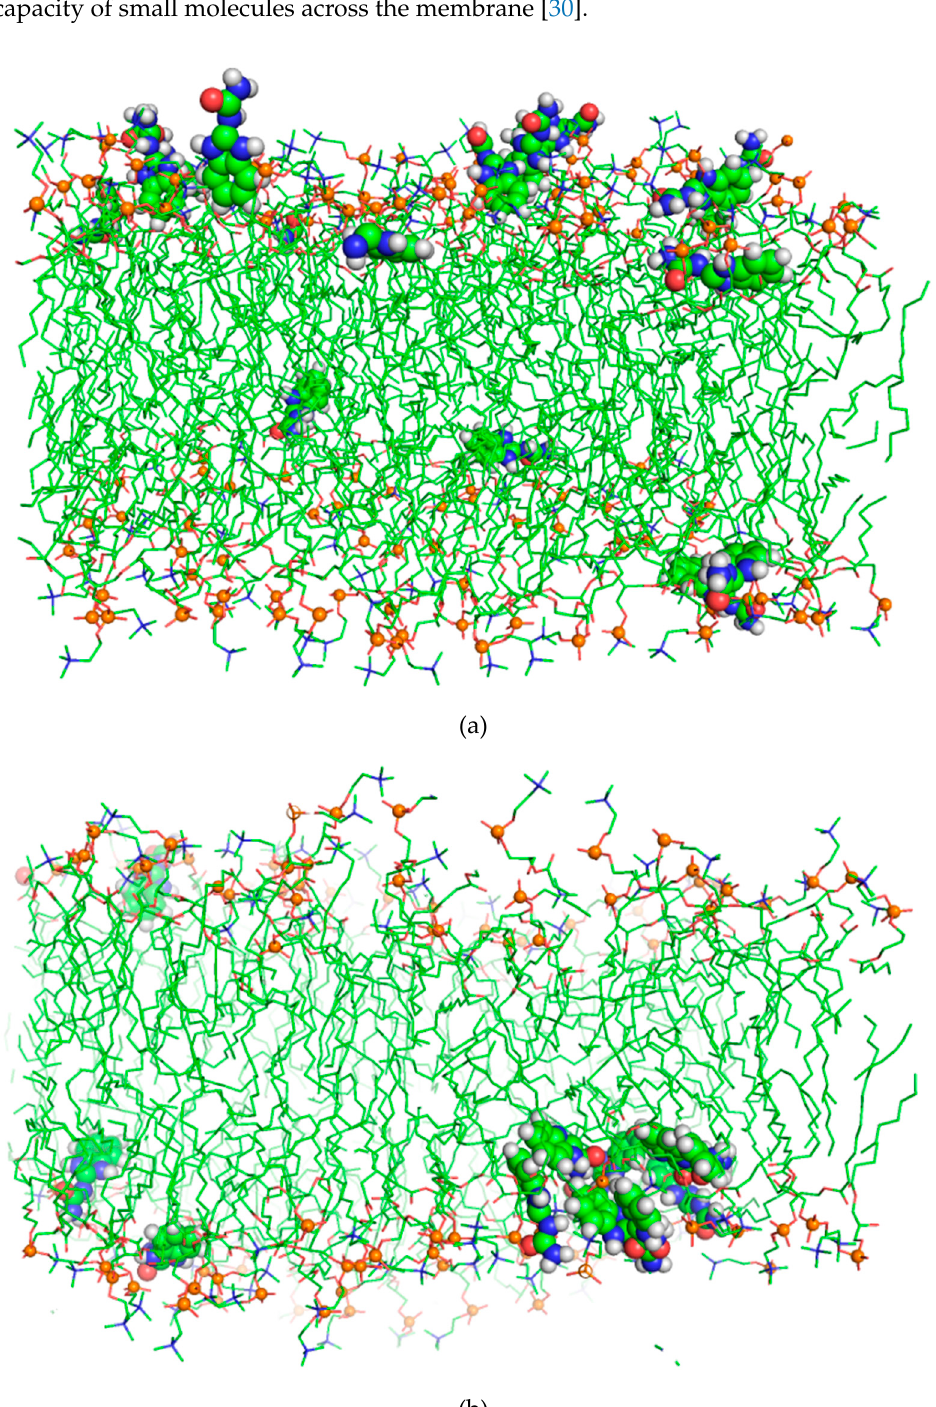
Figure 6. Cluster formation of BZIMU molecules under the effect of a z -axis potential. Snapshots taken at 0.3 ( a ), and 7.4 ns ( b ).